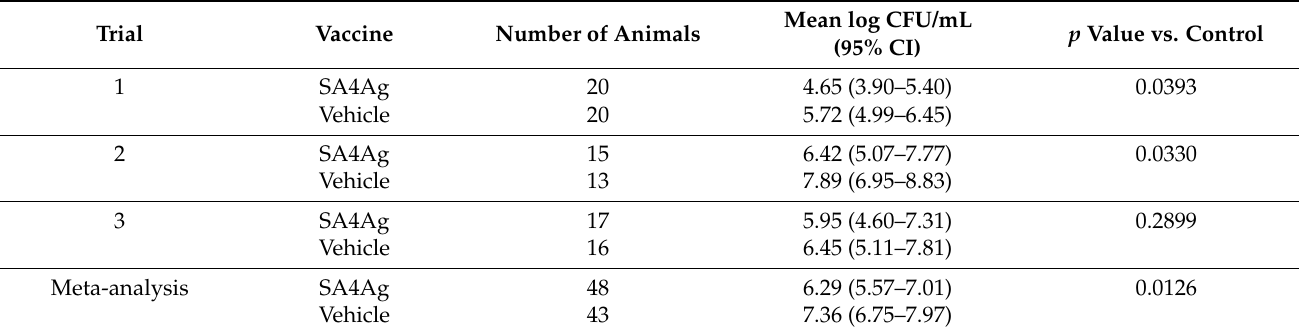
Table 2. Immunization with SA4Ag Reduces S. aureus Burden in a Murine Surgical Site Infection Model.